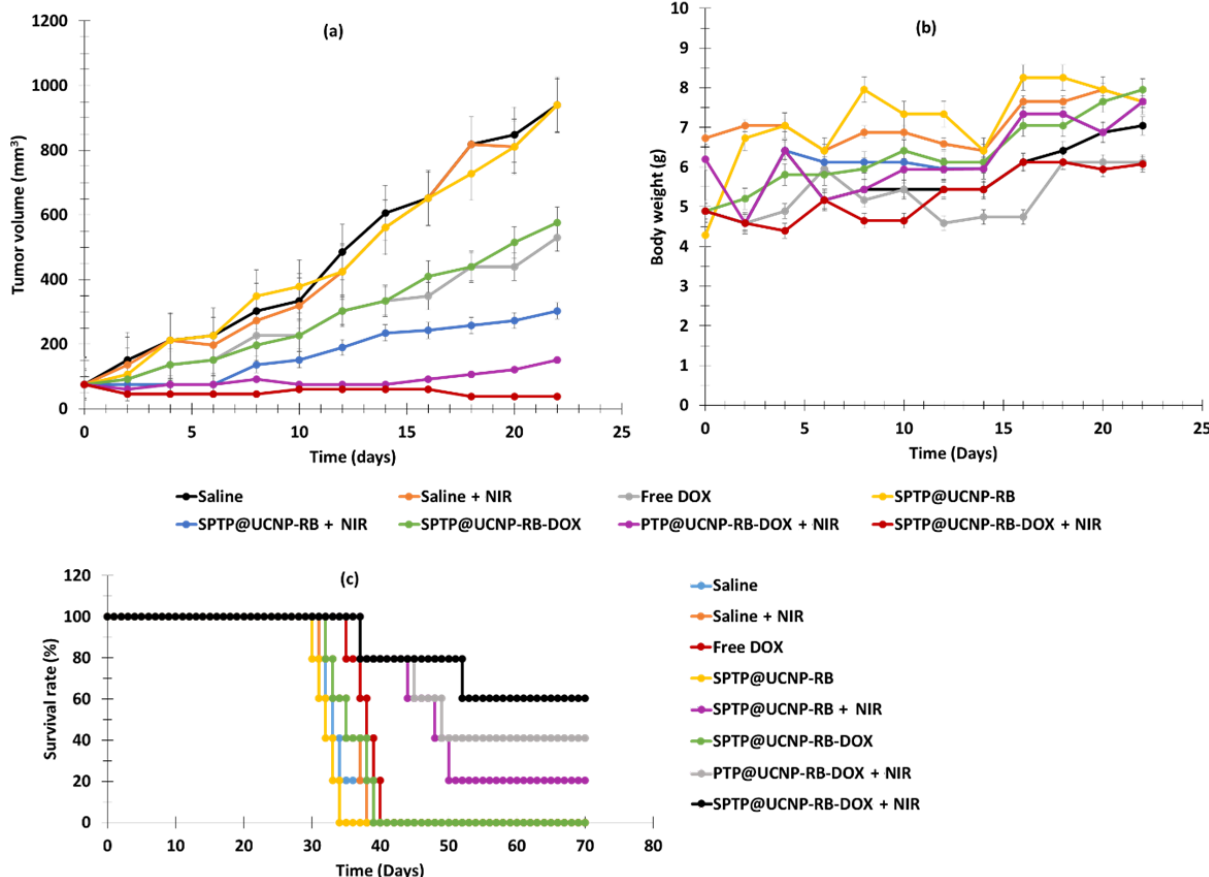
Figure 21. In vivo antitumor effect. ( a ) Tumor volume for different treatment groups ( n = 6). ( b ) Change in body weight of mice over 23 days. ( c ) Changes in survival rate in different groups. Light irradiation at a wavelength of 980 nm, 0.5 W/cm 2 , for 5–10 min (SPTP: 50 µg/mL, DOX: 2.5 µg/mL and RB: 2.5 µg/mL). Adapted from Jin et al. [42].